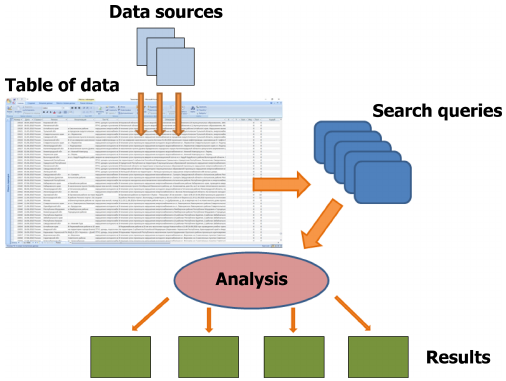
Figure 3. Relational structure of the